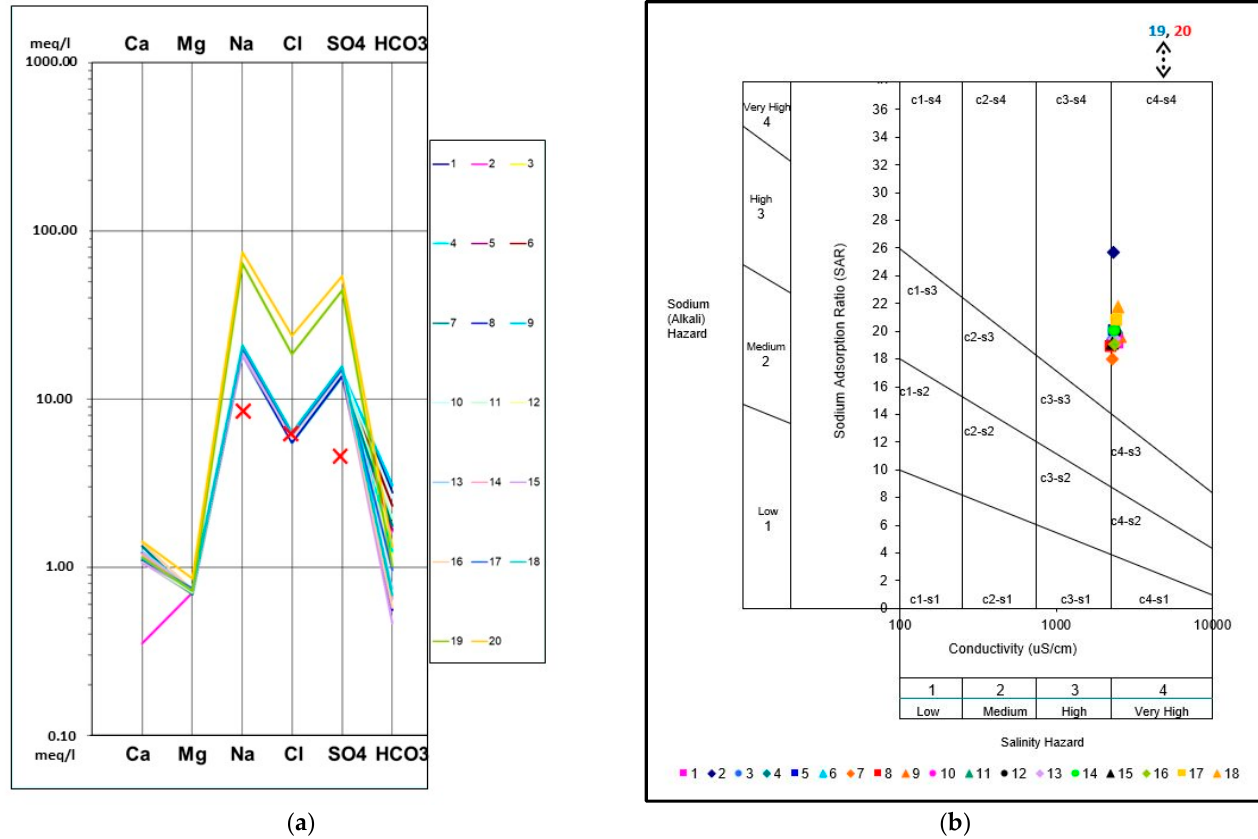
Figure 5. ( a ) Schöeller-Berkaloff diagram highlighting the geochemical behavior of water in the Sochagota Lake. Red marks indicate healthy recommended values [25]. ( b ) Salinity Diagram for Classification of Irrigation Waters for Sochagota Lake. Samples 19 and 20 are omitted from the plot (19-SAR: 66; 20-SAR: 70). Legend for water quality in this plot is: c1-s11: Very Good; c1-s2, c2-s1, c2-s2: Good; c1-s3, c2-s3, c3-s1: Medium; c1-s4, c2-s4, c4-s1, c3-s2: Bad; c3-s3, c3-s4, c4-s3, c4-s4: Very